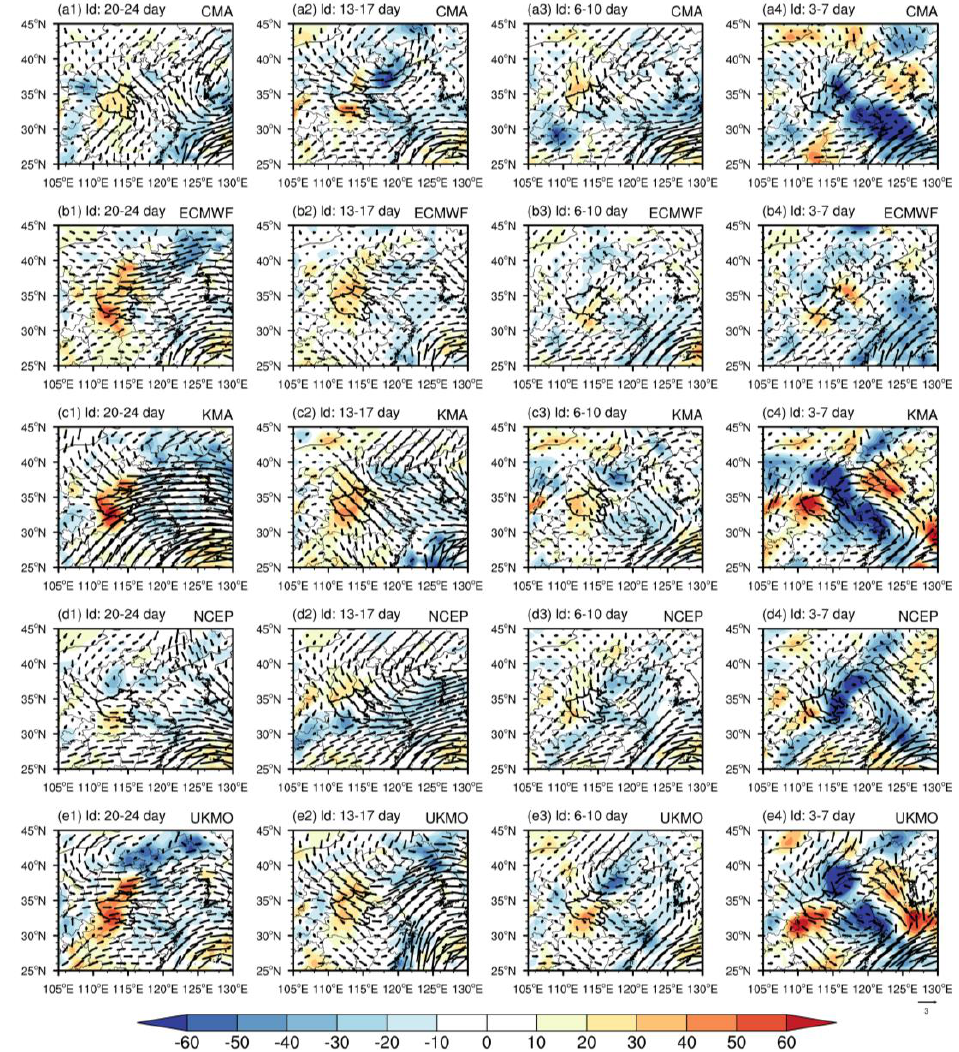
Figure 10. Spatial distribution of the difference in average water vapor fluxes (vector, 10 × 10 2 kg/(m · s )) and their convergence/divergence (shading, 10 × 10 −5 kg/(m 2 · s )) between model prediction and observation during 18 – 22 July in Henan Province.